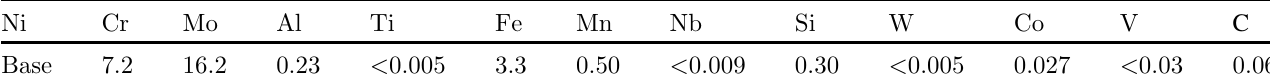
Table 2. Chemical composition of Hastelloy N alloy specimens (UNS#10003) (in wt.%).